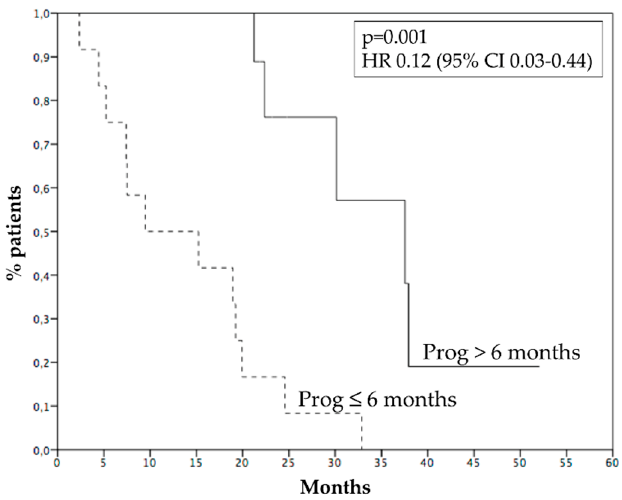
Figure 3. Survival of patients progressed after 6 months (37.5 months, solid line) and within 6 months (9.4 months, dashed line). Prog: progression.